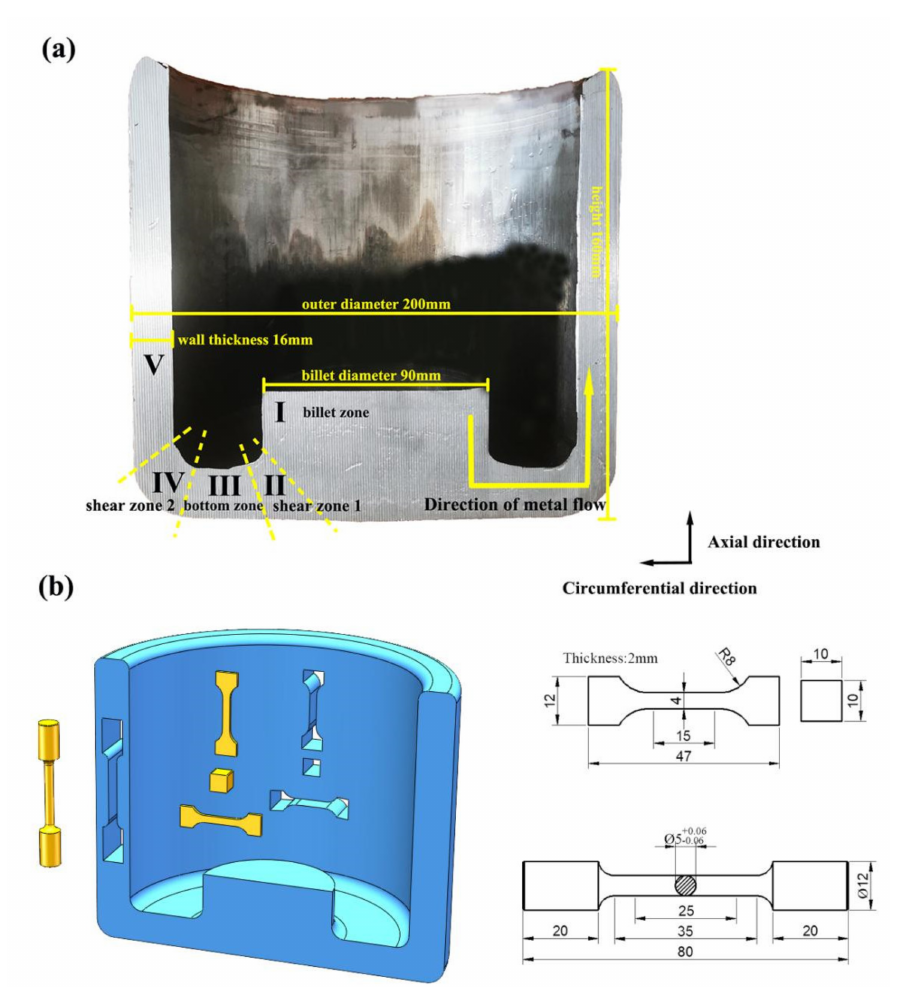
Figure 2. ( a ) anatomical diagram of extrusion cabin; ( b ) schematic diagram of microstructure obser- vation and mechanical properties